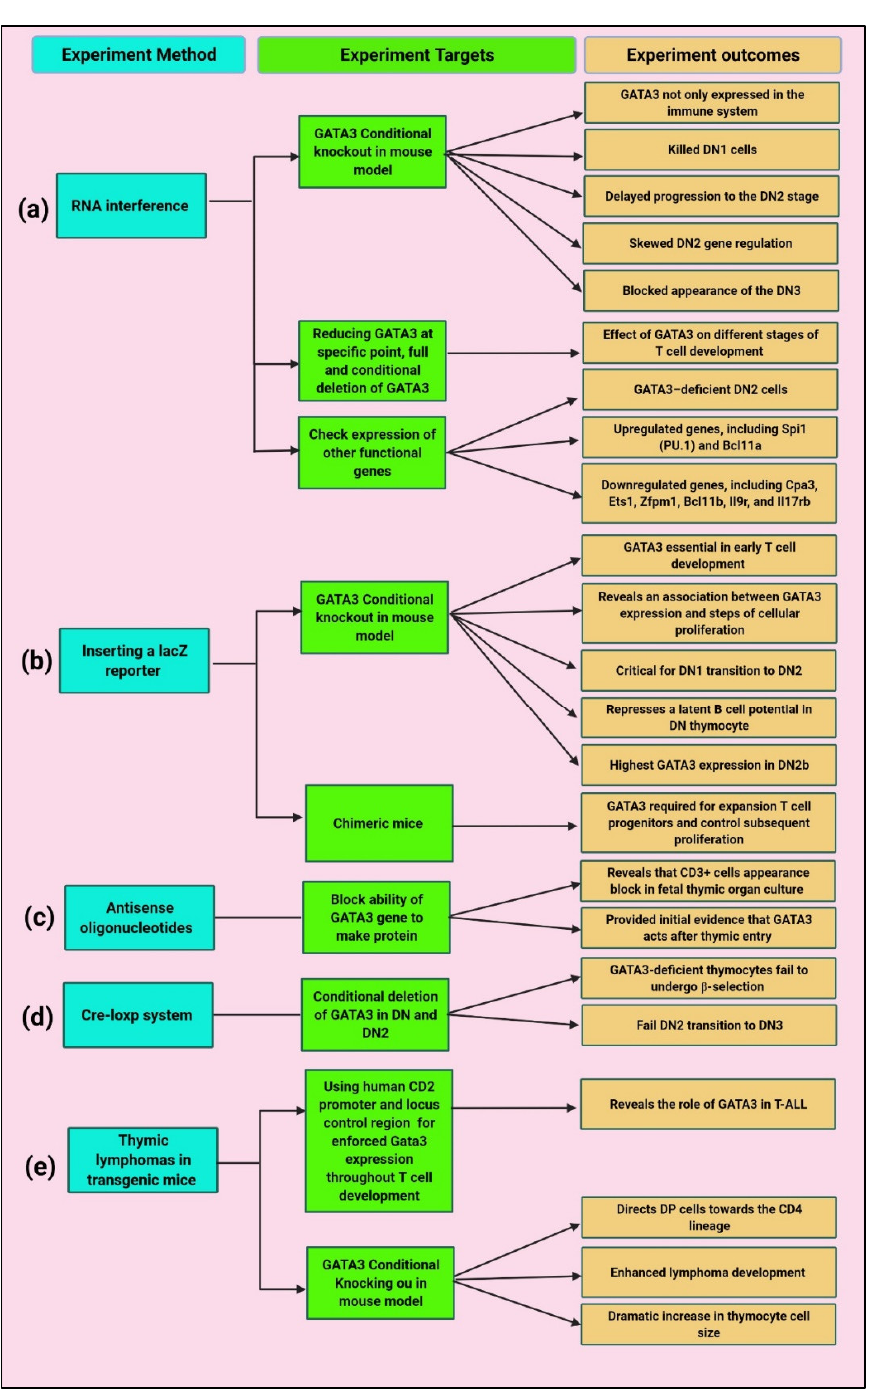
Figure 3. Experimental evidence of the determinate role of GATA3 in T cell development through using different experimental methods: ( a ) RNA interference used for reducing GATA3 during T cell development, inducing GATA3 conditional knocking out in mouse model, and check gene